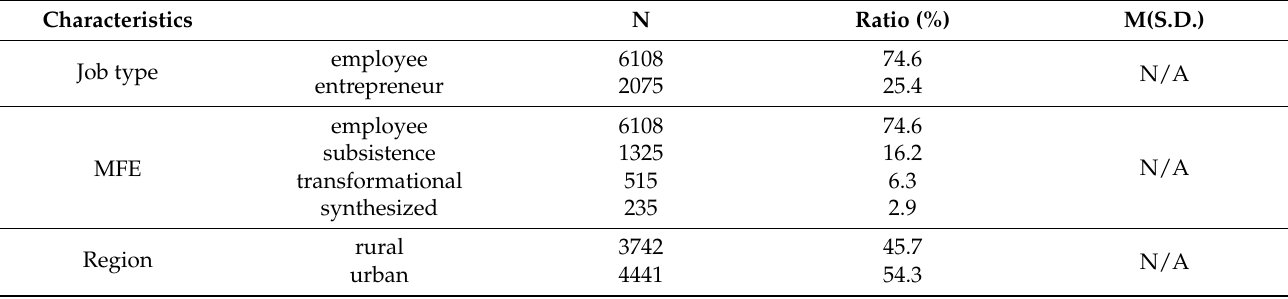
Table 1. Characteristics of the full